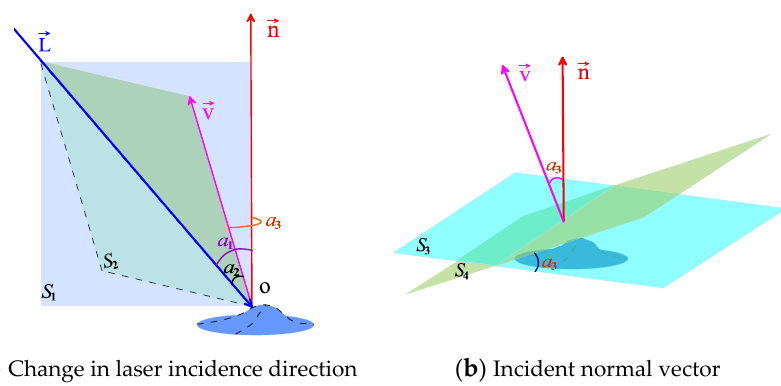
Figure 4. Wave inclination and the change in the laser incident normal vector.